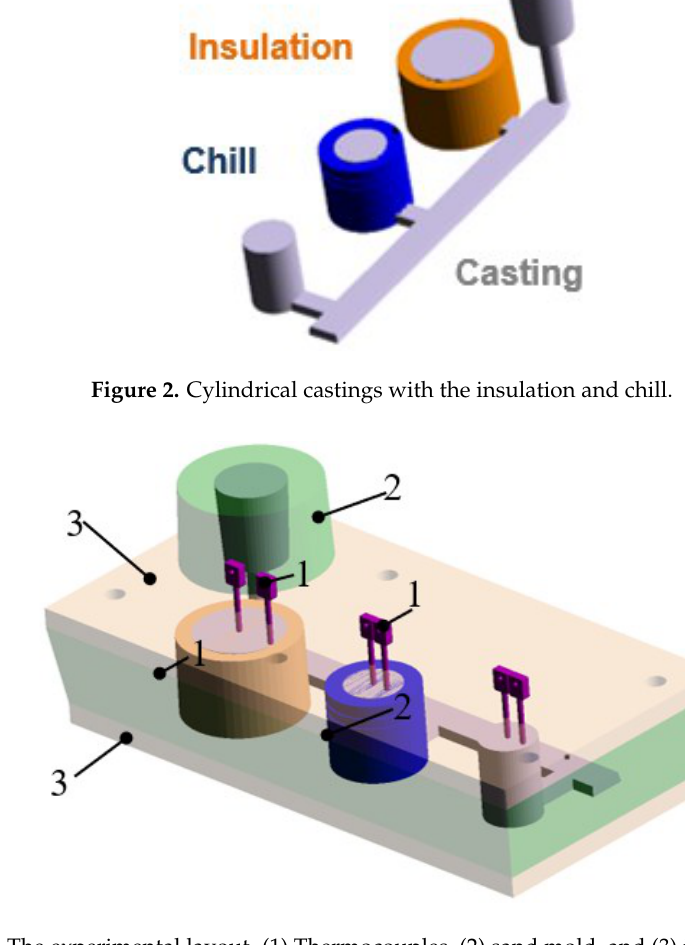
Figure 3. The experimental layout. (1) Thermocouples, (2) sand mold, and (3) insulation plates.